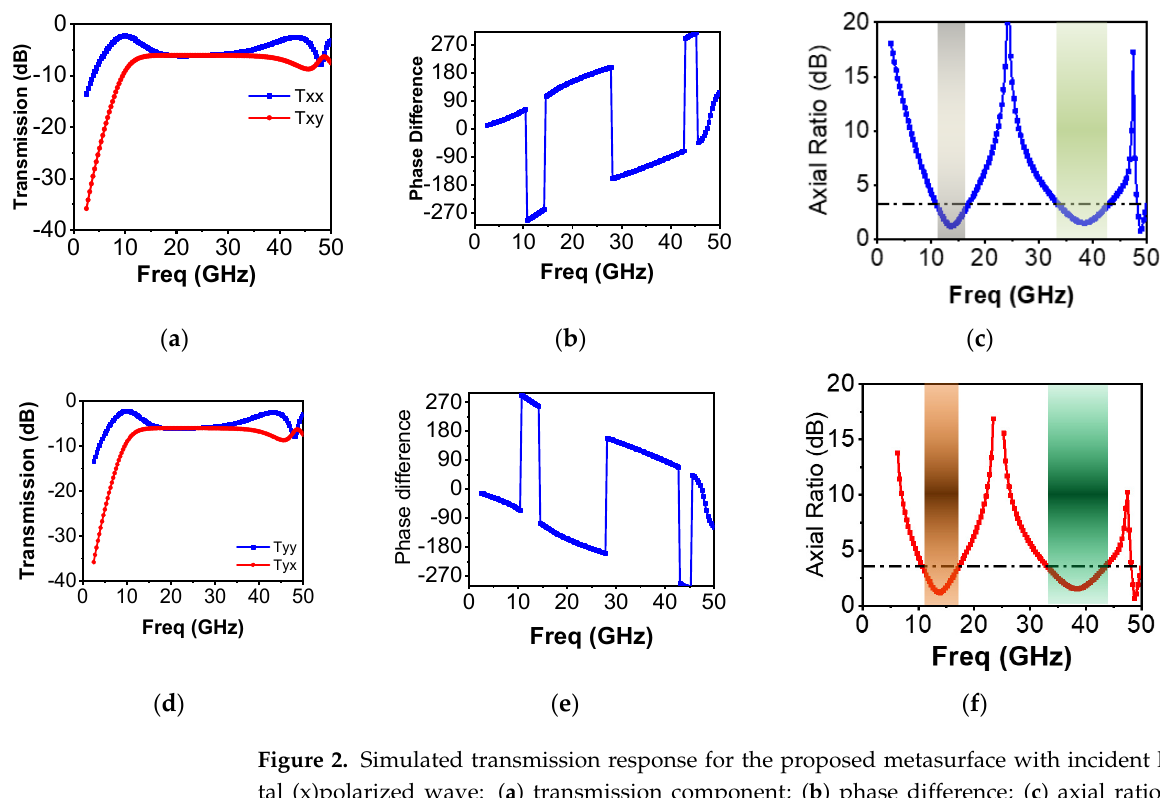
Figure 2. Simulated transmission response for the proposed metasurface with incident horizontal (x)polarized wave: ( a ) transmission component; ( b ) phase difference; ( c ) axial ratio. Simulated trans- mission response with incident vertical (y)polarized wave: ( d ) transmission components; ( e ) phase difference; ( f ) axial ratio (AR).